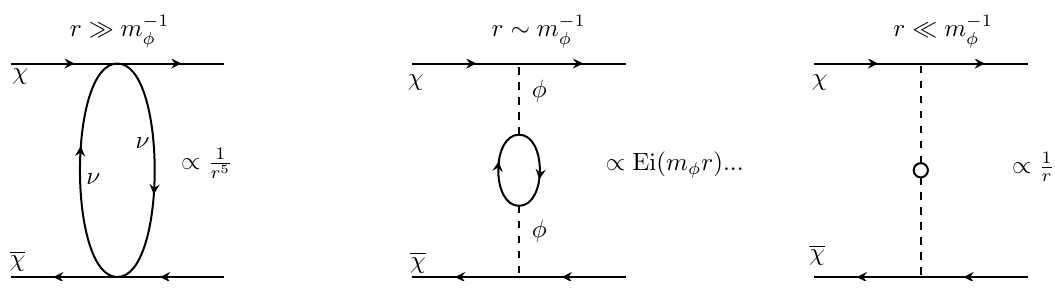
Figure 2 . A diagrammatic explanation of the t -channel neutrino potential varying from the 1 /r 5 to the 1 /r forms. In the long-range limit ( r (cid:29) m − 1 ), the potential decreases as 1 /r 5 . At φ smaller distances ( r ∼ m − 1 ), the contact interaction vertices open up as two φ propagators. The φ resulting potential can be formulated in terms of the exponential integral function, Ei( m ) — see φ r eqs. (3.4)–(3.5). Further reducing r to the short-range limit ( r (cid:28) m − 1 ), the neutrino loop becomes φ subdominant and the potential reduces to the Yukawa/Coulomb-like form, 1 /r